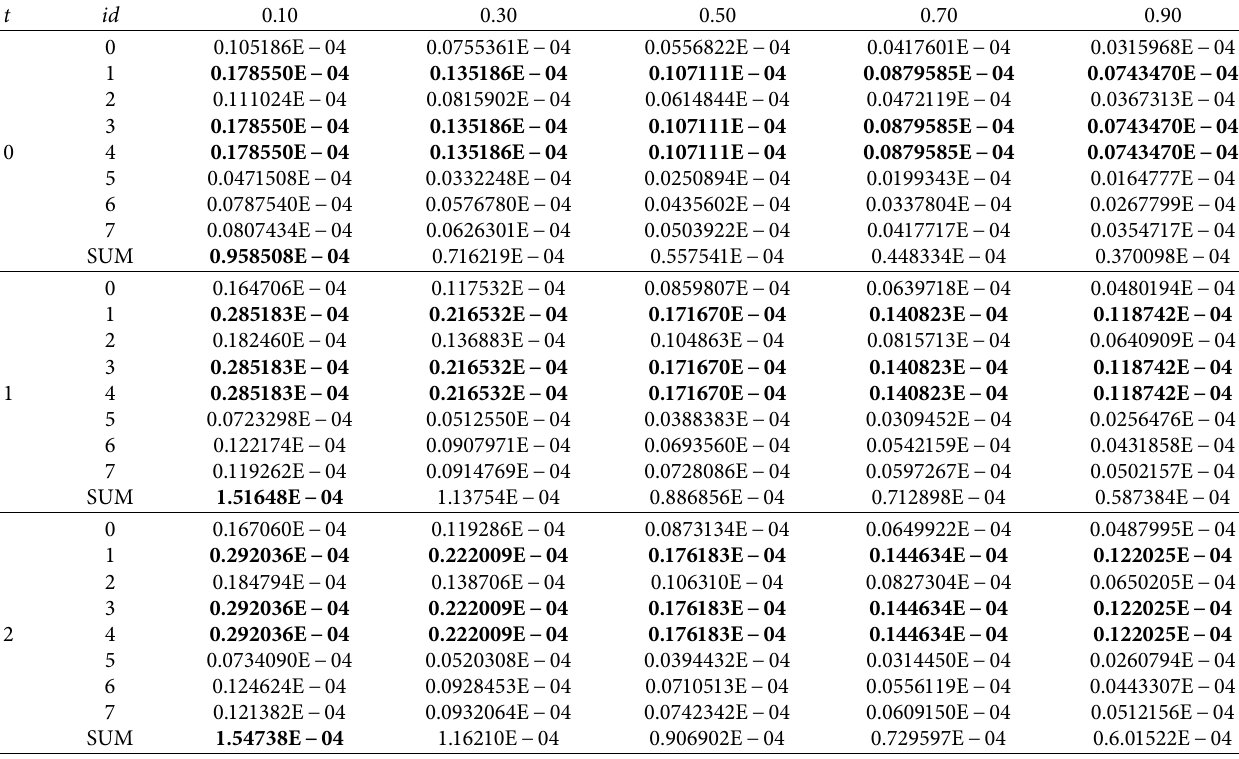
Table 17: Probability that whole network was infected by node i at t � 0, 1, 2, 3.